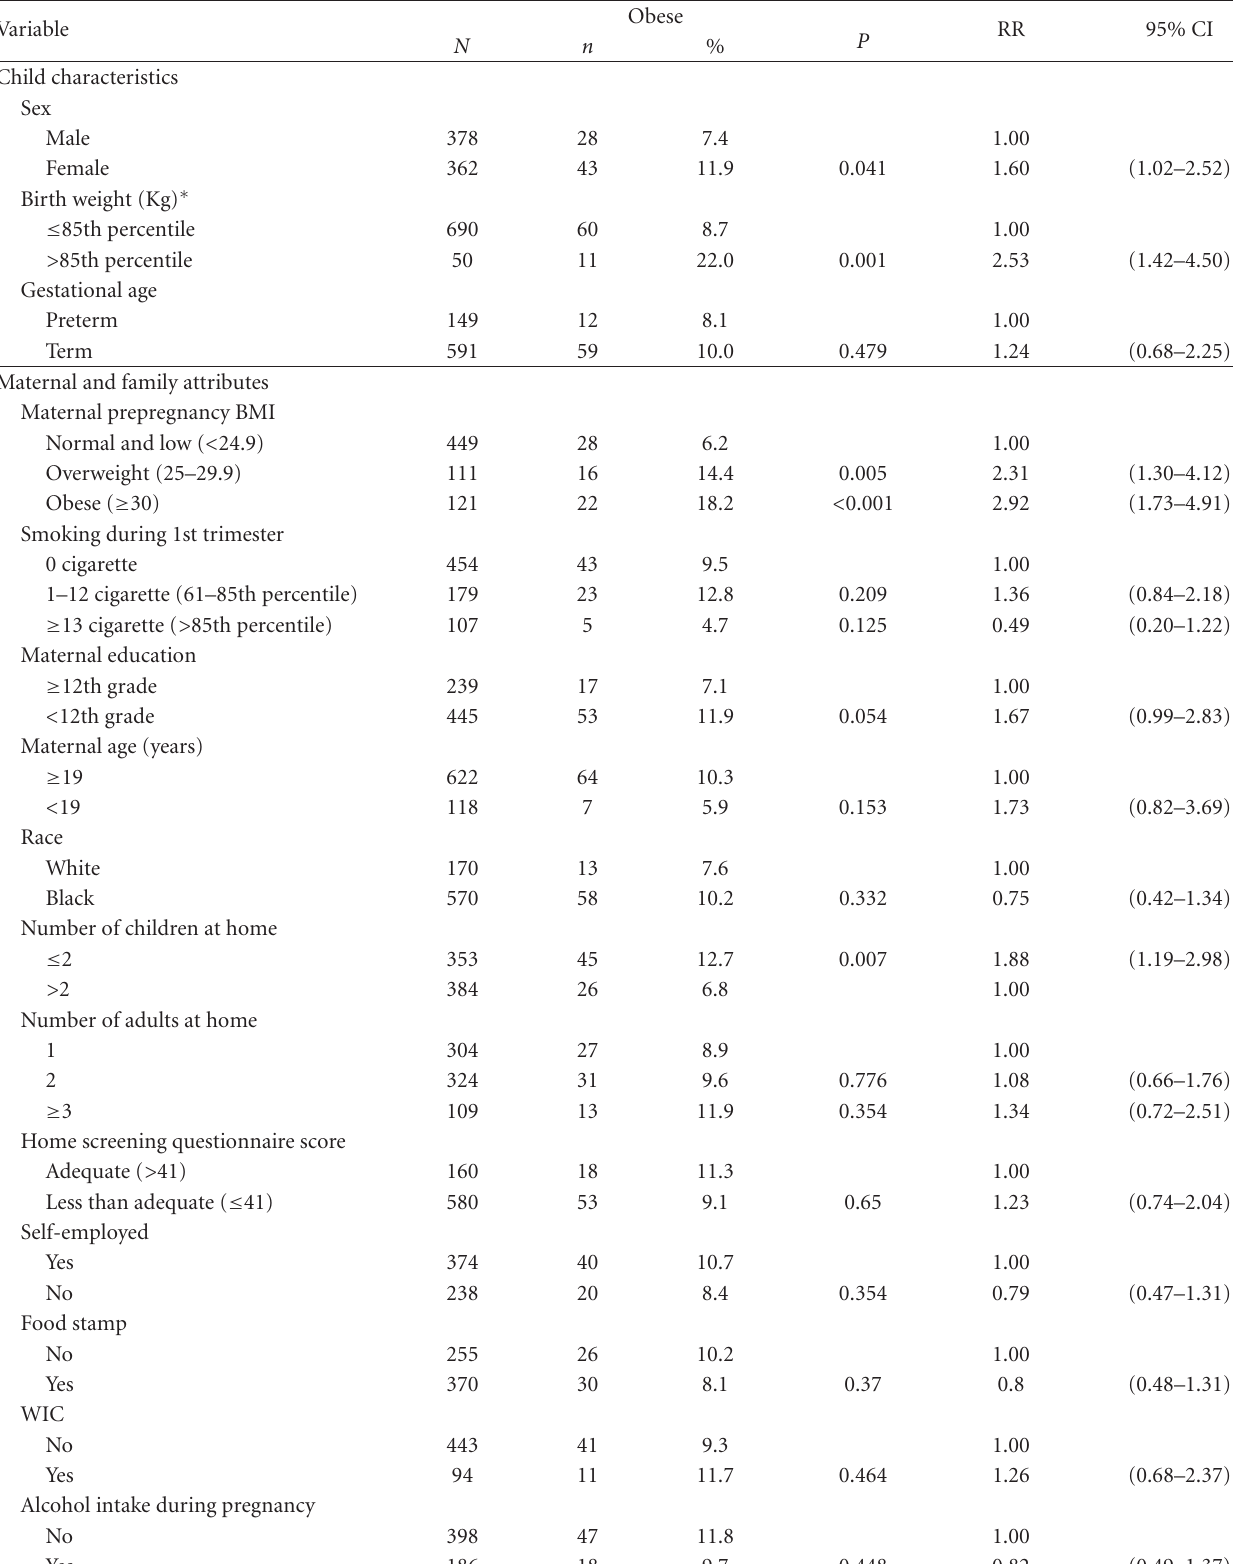
Table 2: Crude risk ratio and 95% CI of prepregnancy and early childhood factors associated with being obese ( ≥ 95th percentile) at the age of